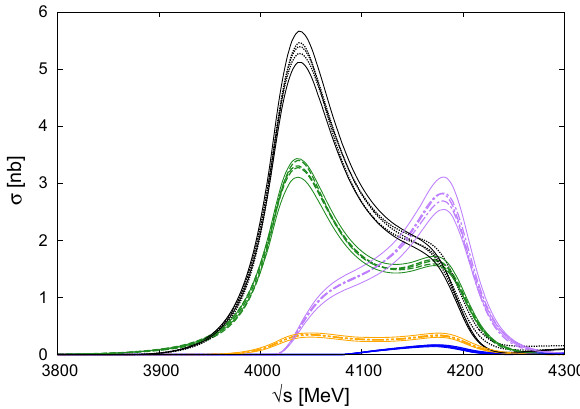
Fig. 7 Different hadronic cross section of σ( e + e − → i i (cid:5) ) without background.Thedashedgreenlinescorrespondtothe σ( D ¯ D ) ,theblack dotted lines the σ( D ¯ D ∗ ) , the purple dash-dotted lines the σ( D ∗ ¯ D ∗ ) , the orange two dot-dashed lines the σ( D + s ¯ D − s ) and the blue solid lines the σ( D s ¯ D ∗ s ) for Set I, Set II and Set III. The most extreme thin